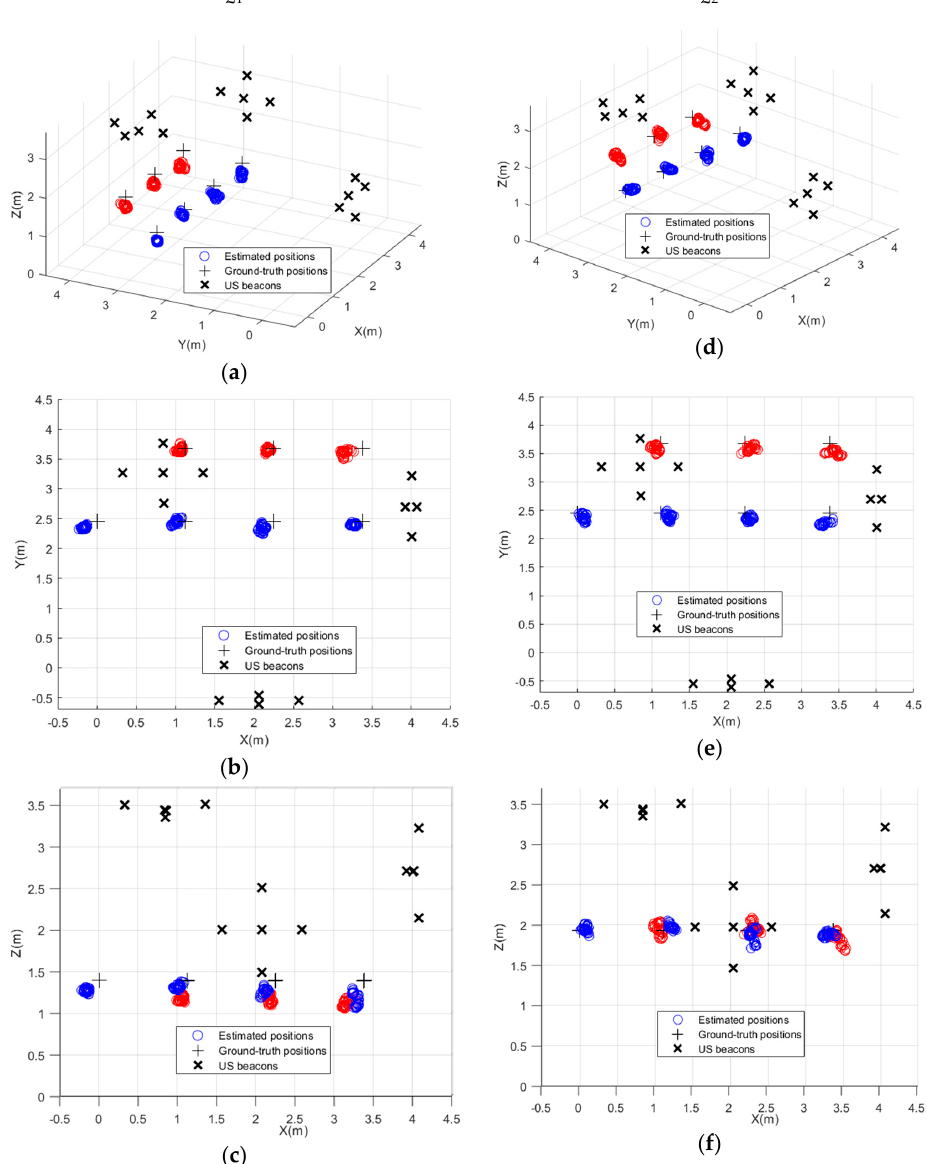
Figure 10. Clouds of estimated positions with an EKF and three ULPSs for σ w = 0.2 m, at z 1 = 1.35 m Figure 10. ( a – f ) Clouds of estimated positions with an EKF and three ULPSs for σ w = 0.2 m, at (left) and z 2 = 1.93 m (right): successively, 3D representation of clouds of points; Y–X projections; z 1 = 1.35 m ( left ) and z 2 = 1.93 m ( right ): successively, 3D representation of clouds of points; Y–X and Z–X projections. projections; and Z–X